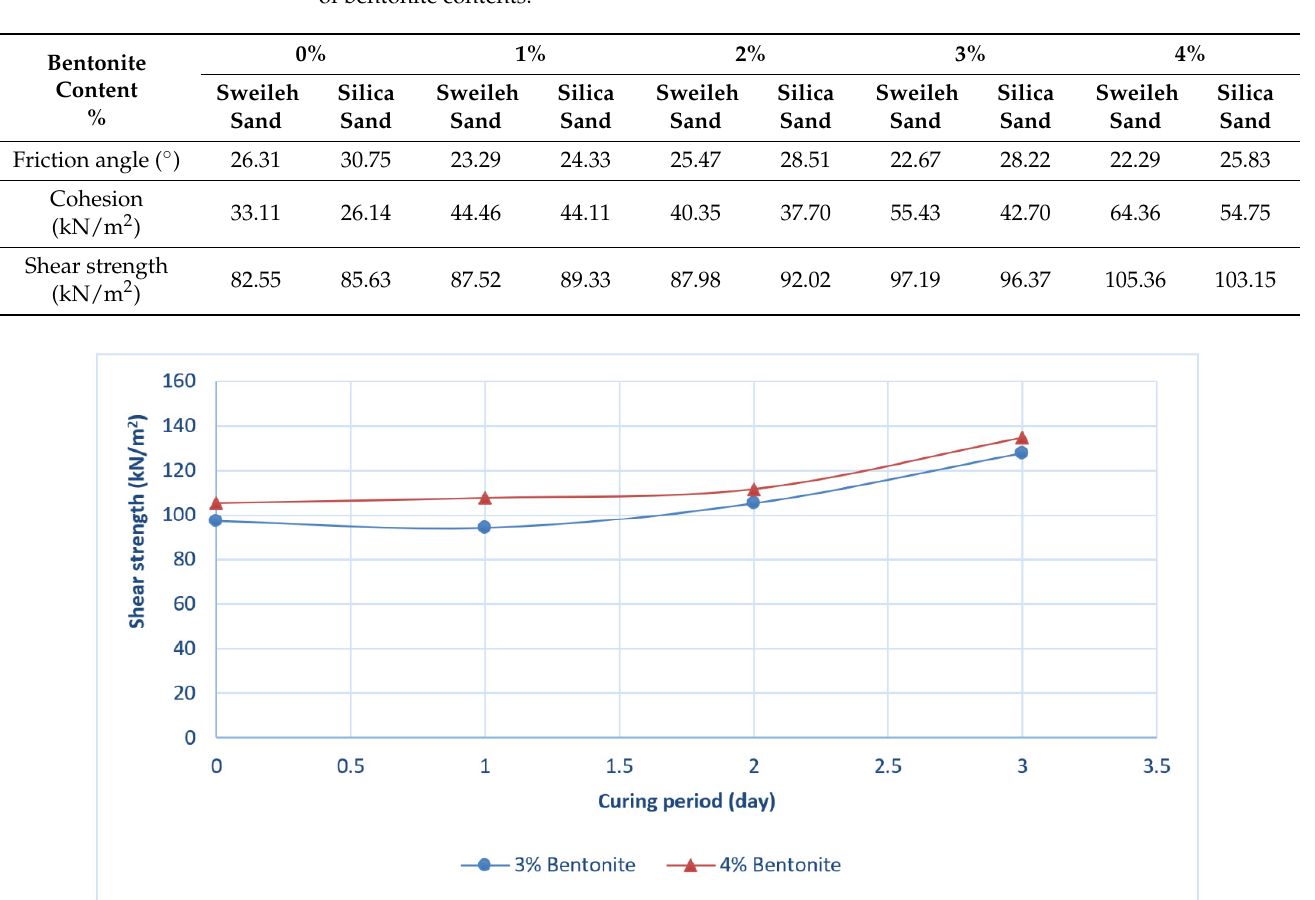
Table 3. Shear strength parameters for Sweileh and silica sandy soils stabilized with various amounts of bentonite contents.